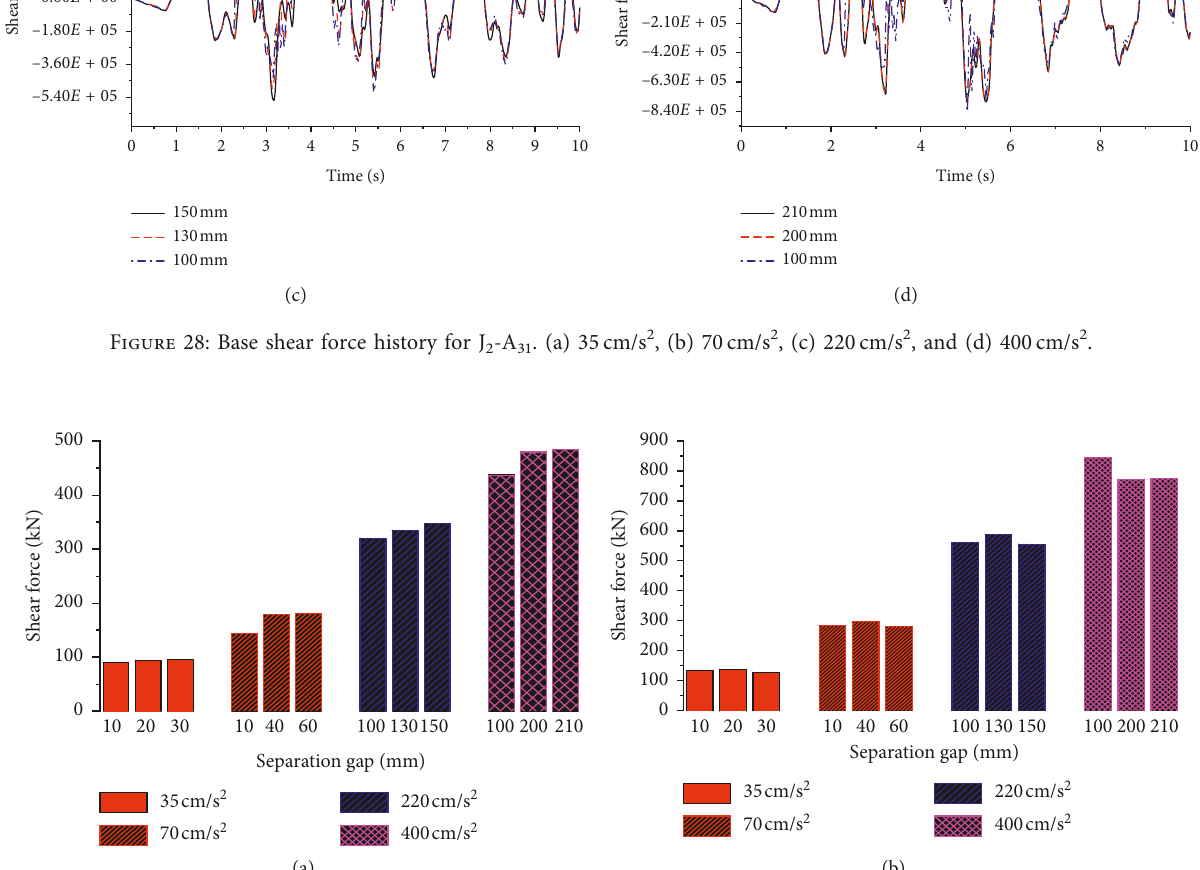
Figure 29: Maximum value of base shear